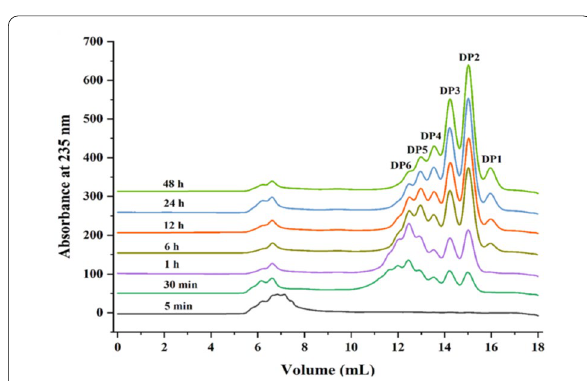
Fig. 7 The FPLC analysis of ErPelPL1 degrading products. The reaction times are: 5 min, 30 min, 1 h, 6 h, 12 h, 24 h, 48 h, respectively. The eluents were detected by measuring the absorbance at 235 nm. The elution volumes of the unsaturated monomer, dimer, trimer, tetramer, pentamer and hexamer are 16.25, 15.23, 14.38, 13.61, 13.01, and 12.89 mL